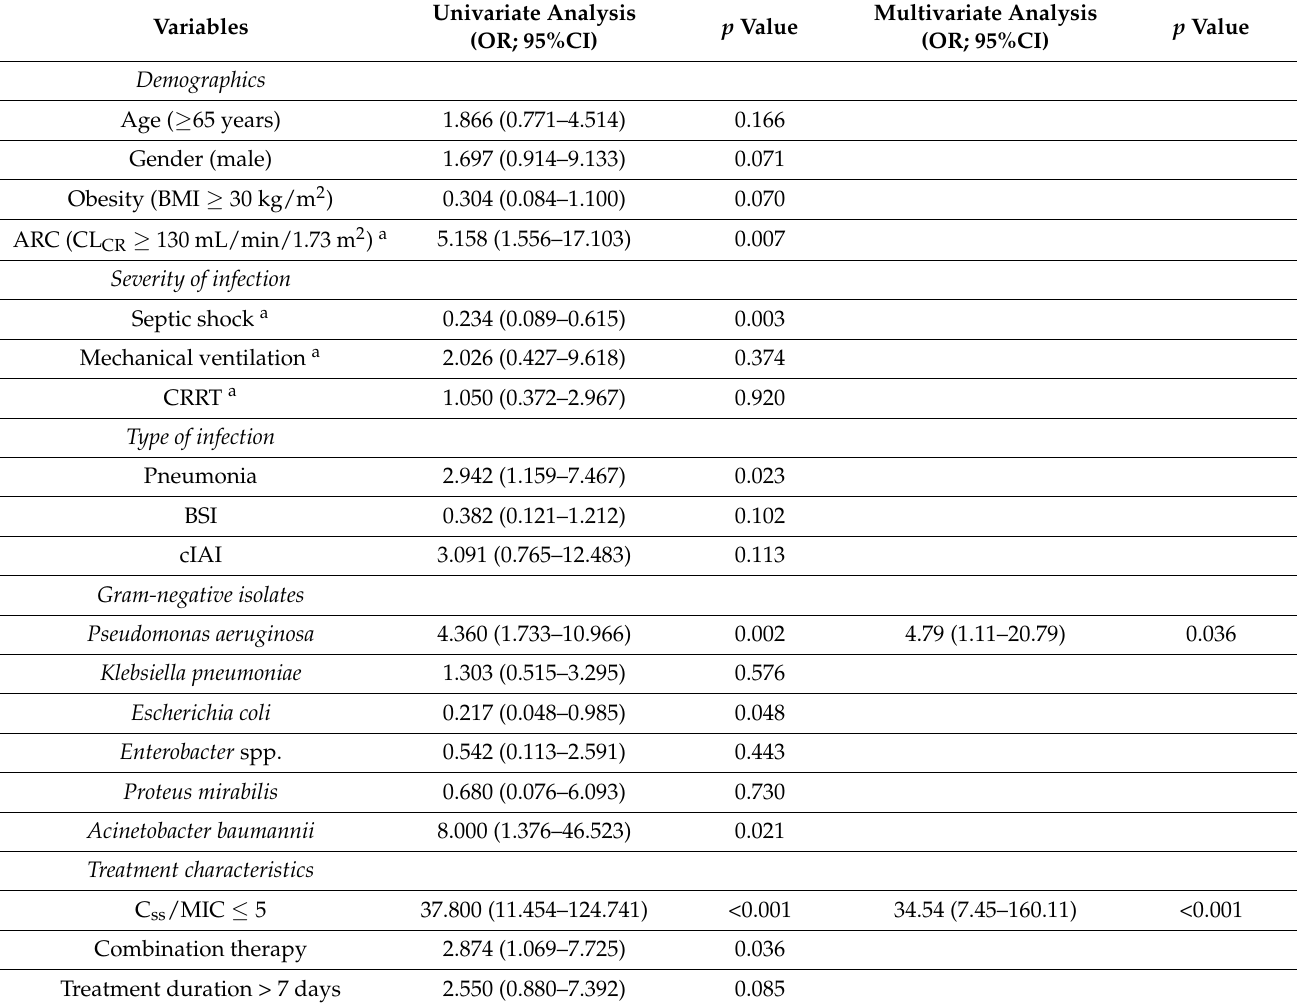
Table 2. Univariate and multivariate logistic regression analysis of variables associated with microbiological failure and/or resistance development (n =